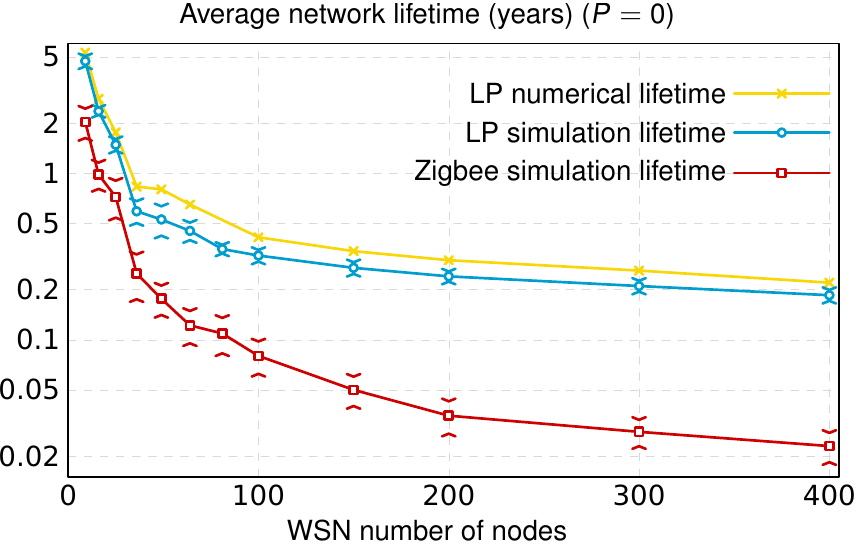
Figure 9. Network lifetime for different numbers of nodes without primary nodes. The simulation results show the average lifetime and its standard deviation obtained from 20 simulations with different seeds (95% confidence interval, Batch Mean